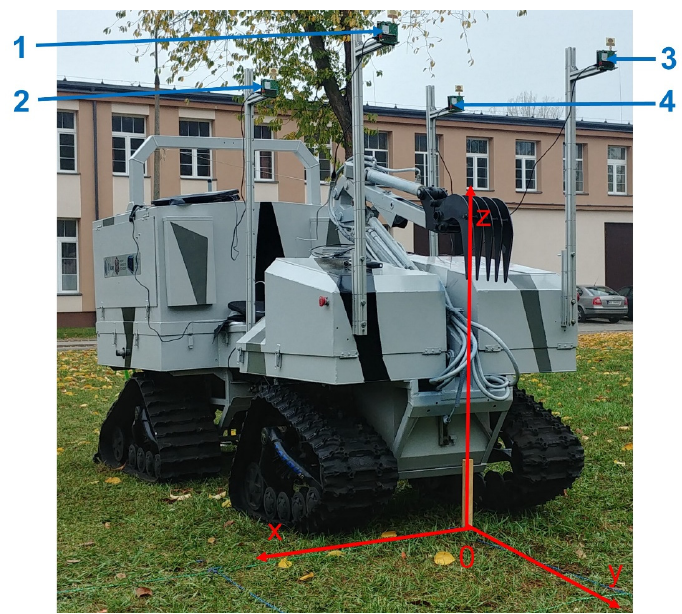
Figure 6. The unmanned ground vehicle with the anchors no. 1,2,3,4 and the adopted coordinate